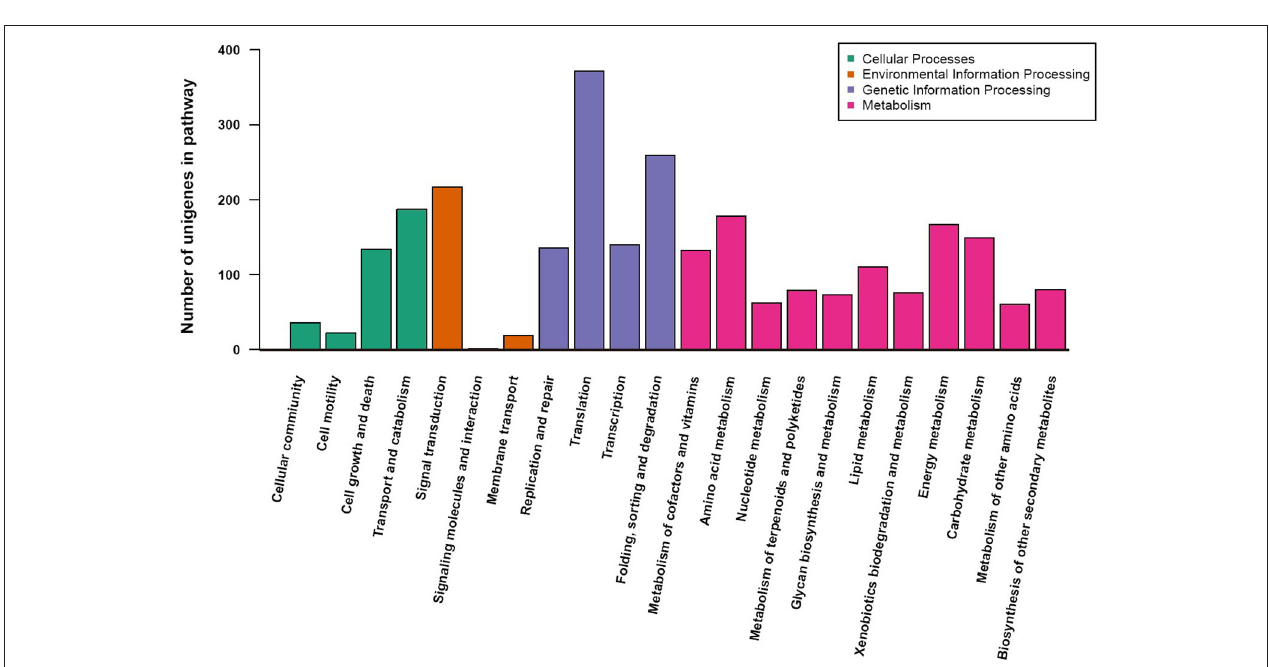
FIGURE 4 | KEGG pathway assignment using a reciprocal BLAST analysis with a E-value cutoff of 1e–5.